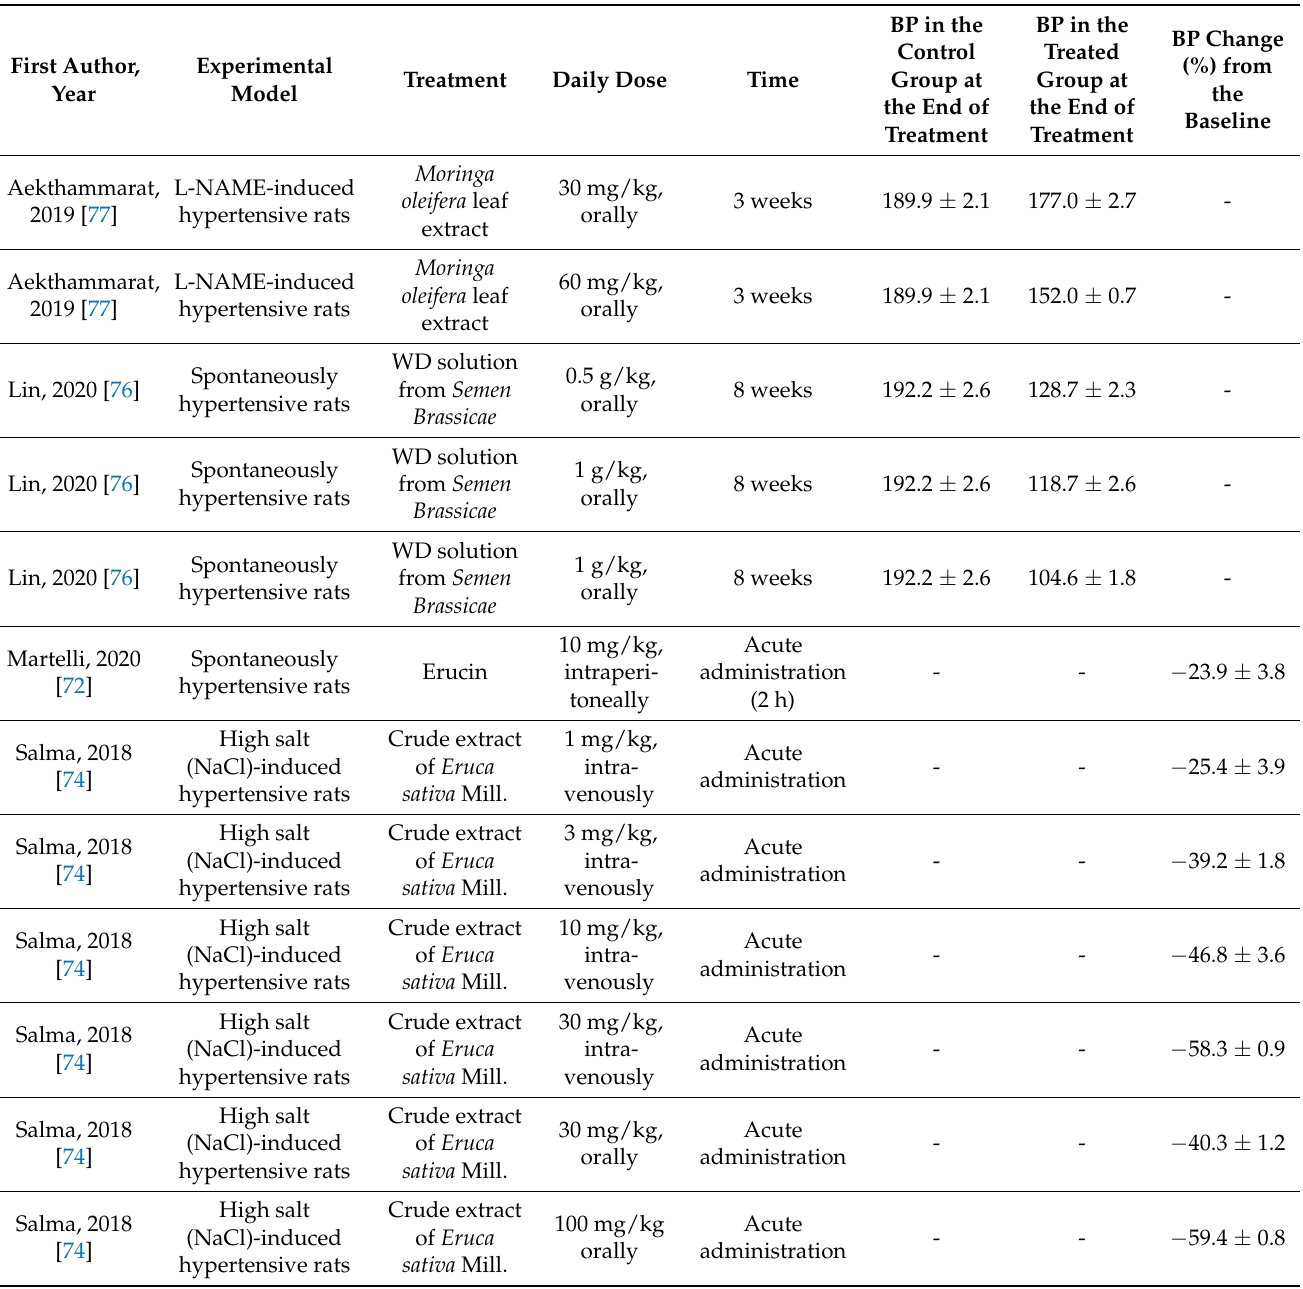
Table 2. Antihypertensive effects of Brassicaceae , Moringaceae, and isothiocyanates (erucin) in preclini- cal studies. Blood pressure (BP) values at the end of treatment were reported for studies evaluating the preventive effects of supplements against BP increase in hypertensive animals, while change (%) in BP was reported for studies directly evaluating the blood pressure-lowering effects of supplements in animals with hypertension. All values refer to systolic BP (mmHg) reported as mean ± SEM. WD: water